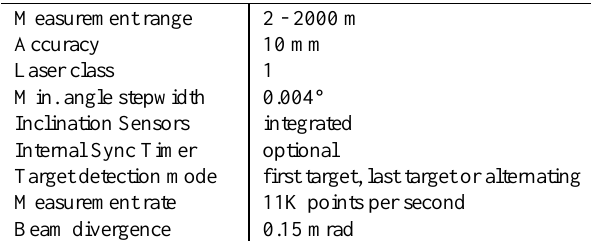
Table 1. Characteristics of Riegl LMS Z620 TLS instrument used in survey.